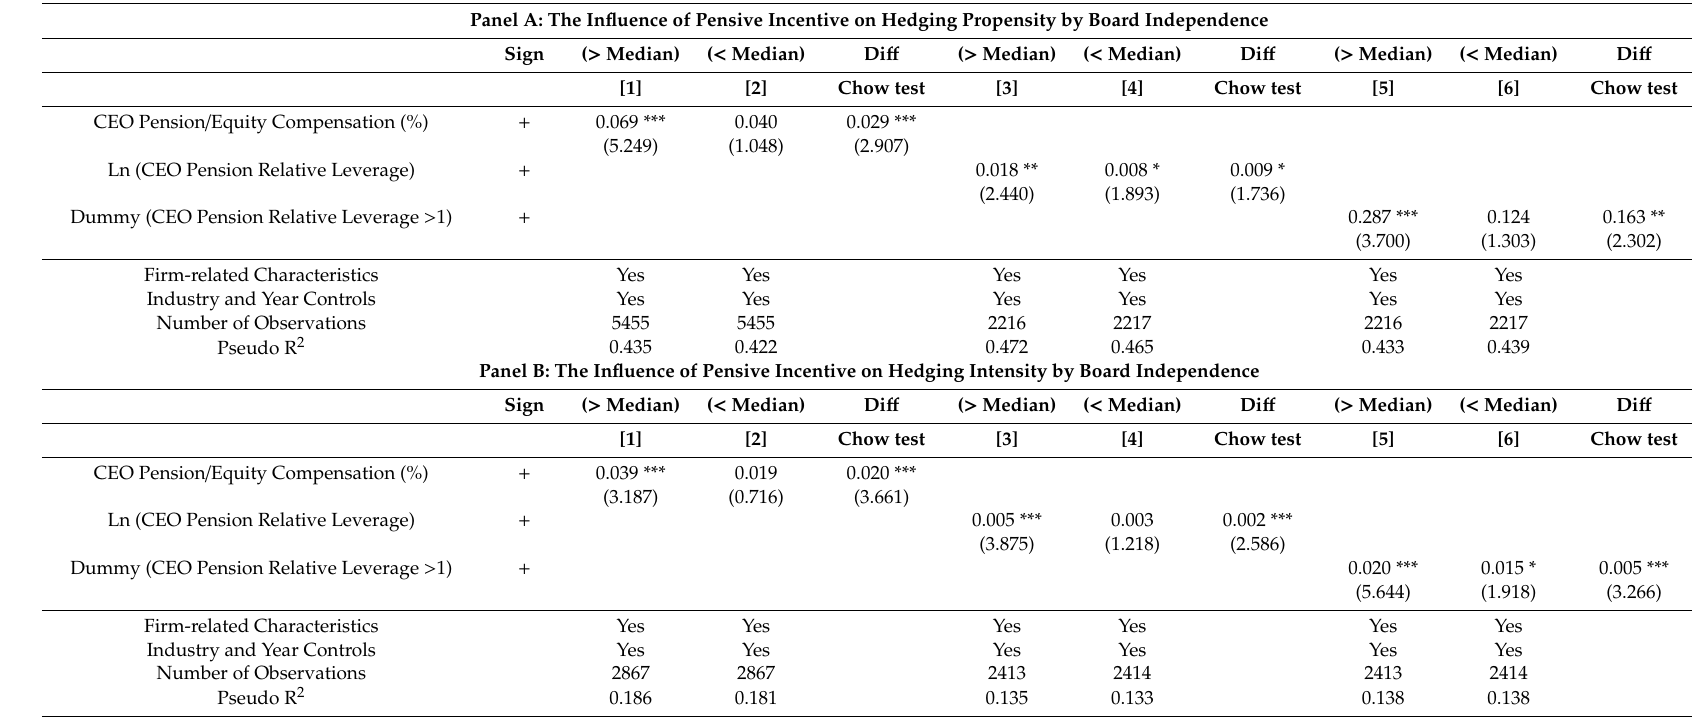
Table 6. The influence of pension incentive on hedging by board independence. Panel A: The Influence of Pensive Incentive on Hedging Propensity by Board